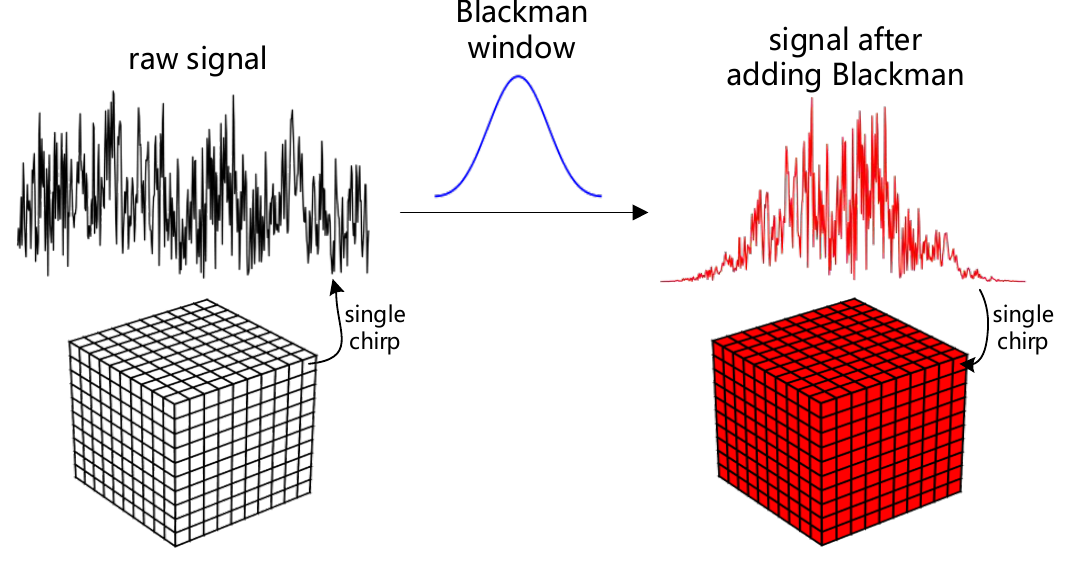
Figure 4. Procedure of